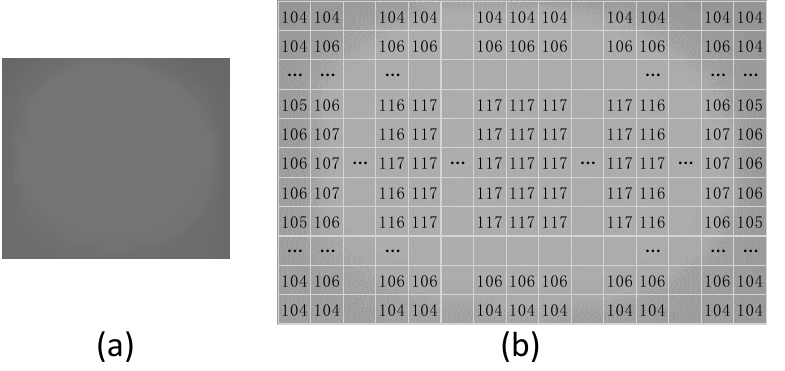
Figure 3. The circular image template of breast mass for image template matching method. Where ( a ) is the template image used to match the suspected regions of breast mass in the processed image. The pixel values of the template image of breast mass are shown in ( b ).